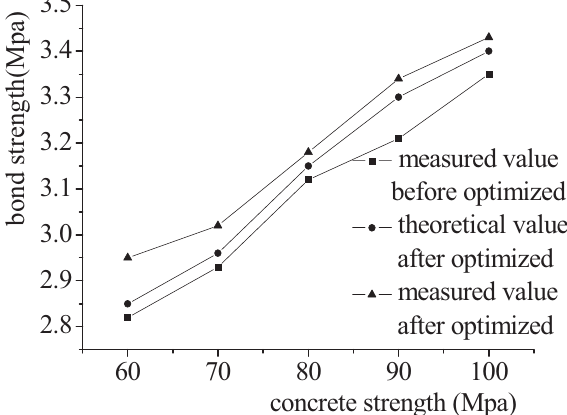
Fig. 4. Comparative analysis of ultimate bond